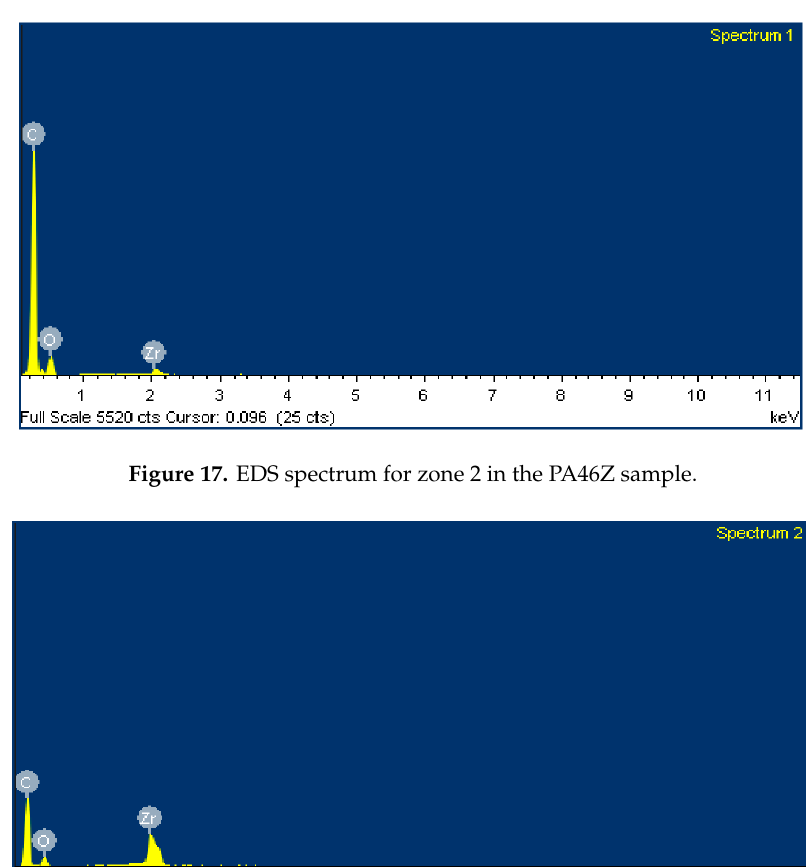
Figure 16. SEM image for zone 2 in the PA46Z sample.